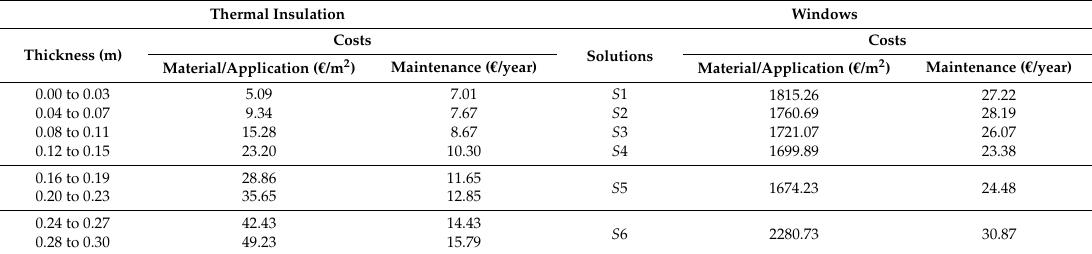
Table 8. Installation costs of variable’s investment input for life cycle cost (LCC) analysis. Thermal Insulation Windows Costs Thickness (m) Solutions